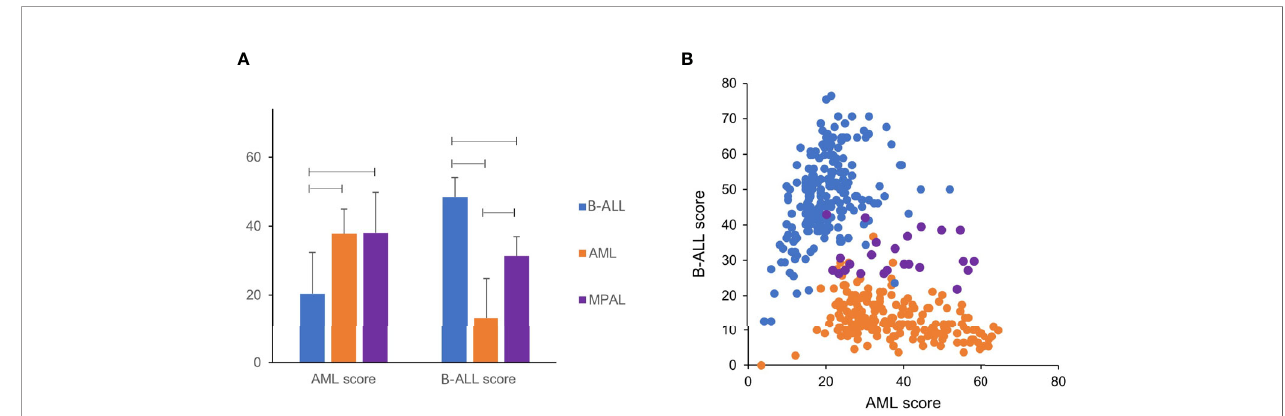
FIGURE 2 | AML score and B-ALL score of public data. (A) Except AML score between AML and MPAL, AML score and B-ALL score between each leukemia were signi fi cantly different (p < 0.01). (B) Public data of AML and B-ALL show clustering in scatter plot of AML score and B-ALL score. MPAL samples cluster between AML and B-ALL samples.